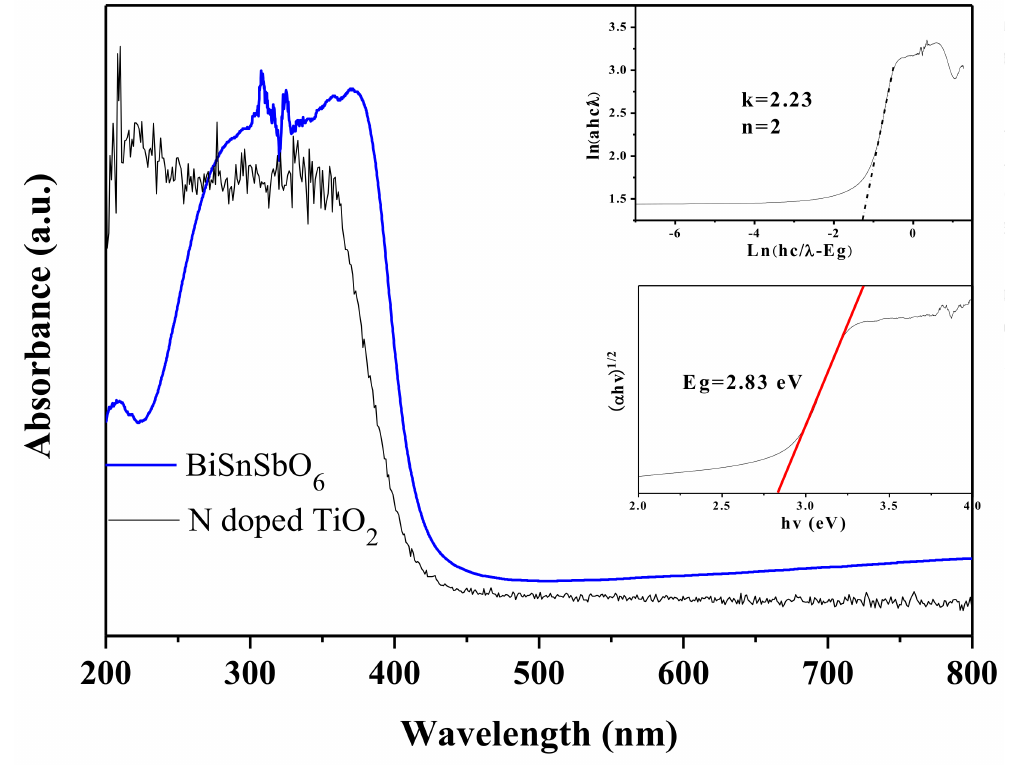
Figure 4. UV-Vis diffuse reflectance spectra of BiSnSbO 6 and N-doped TiO 2 (inset was plot of ln( α h ν ) versus ln( h ν − E g ) or plot of ( α h ν ) 1/2 versus h ν for BiSnSbO 6